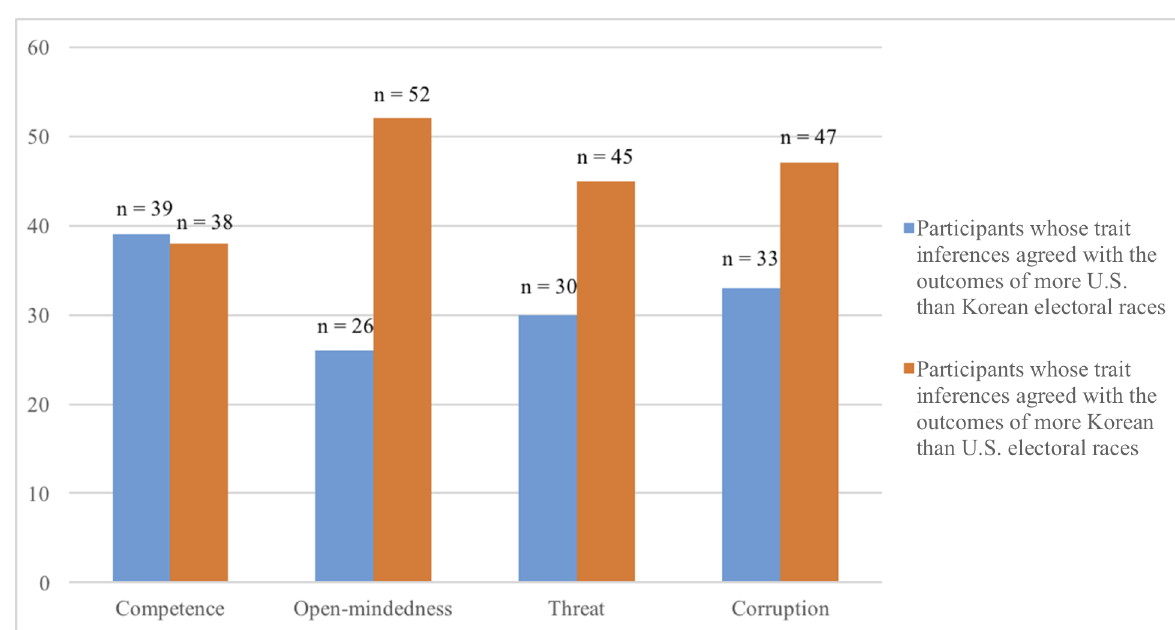
Fig 2. The number of participants whose trait inferences agreed with the outcomes of more electoral racesin one country than the other. The blue histogramrepresents the numbers of participants whose trait inferences agreedwith the outcomesof more U.S. than Korean elections.The orangehistogram represents the numbers of participants whose trait inferences agreedwith the outcomesof more Korean than U.S. elections.For brevity, the category U.S. = Korean was omitted from the graph. All participants(N = 80).